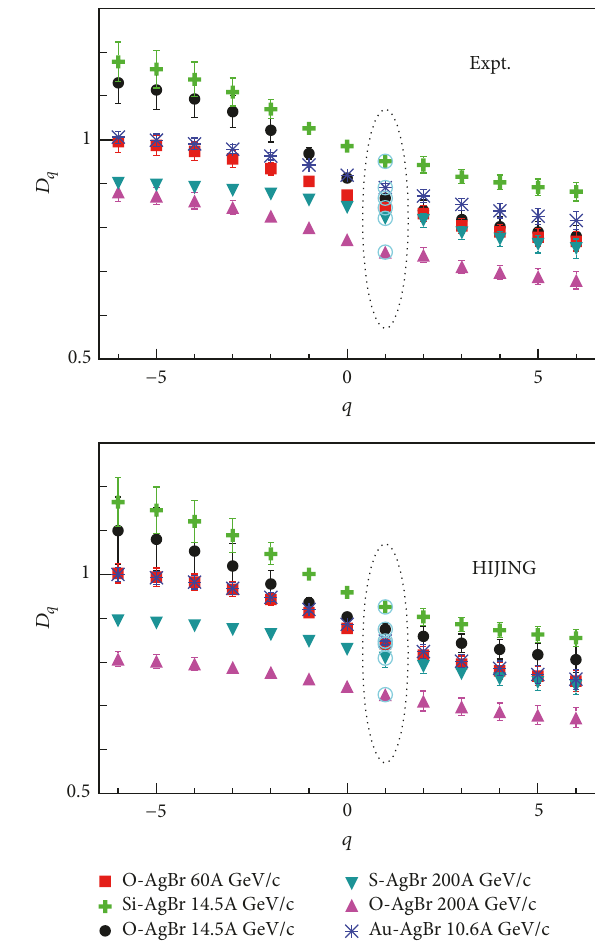
Figure 3: Variations of 𝑆/𝑆 max with ⟨𝑛⟩/⟨𝑛⟩ max for the experimental and HIJING event samples.